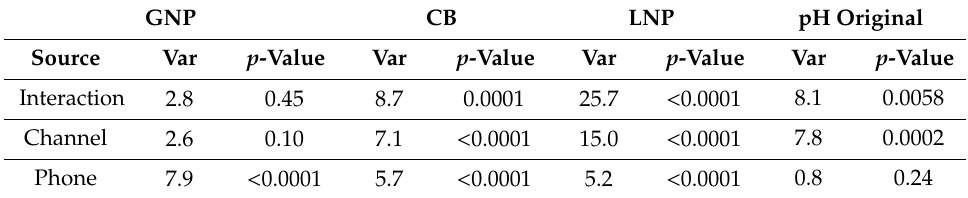
Table 4. Two-way ANOVA on phone model and channel for GNP, CB, LNP, and pH predictions.